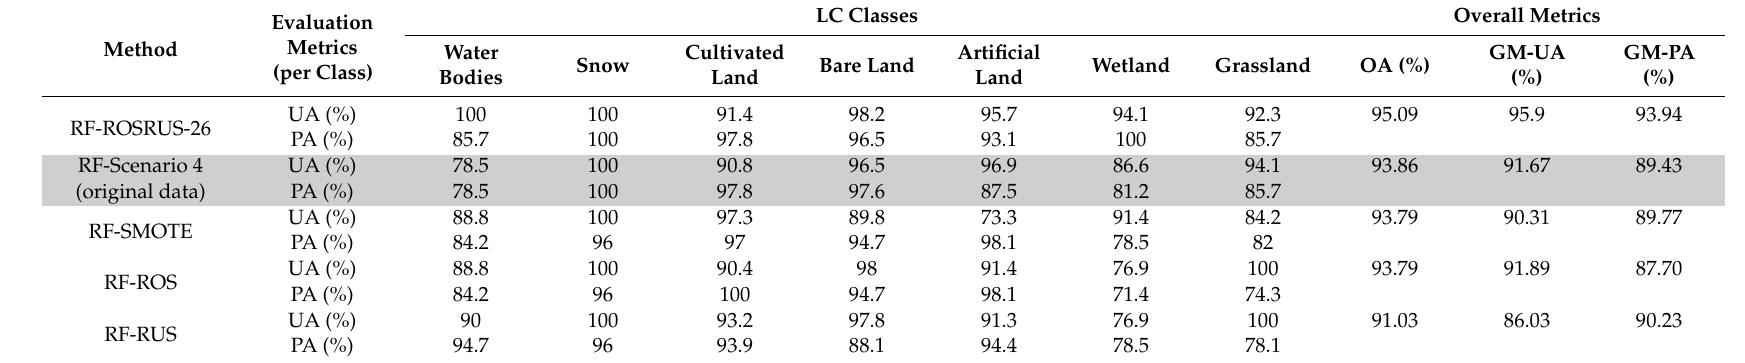
Table A4. Accuracy assessment of the four data balancing methods and traditional RF (Scenario-4) over